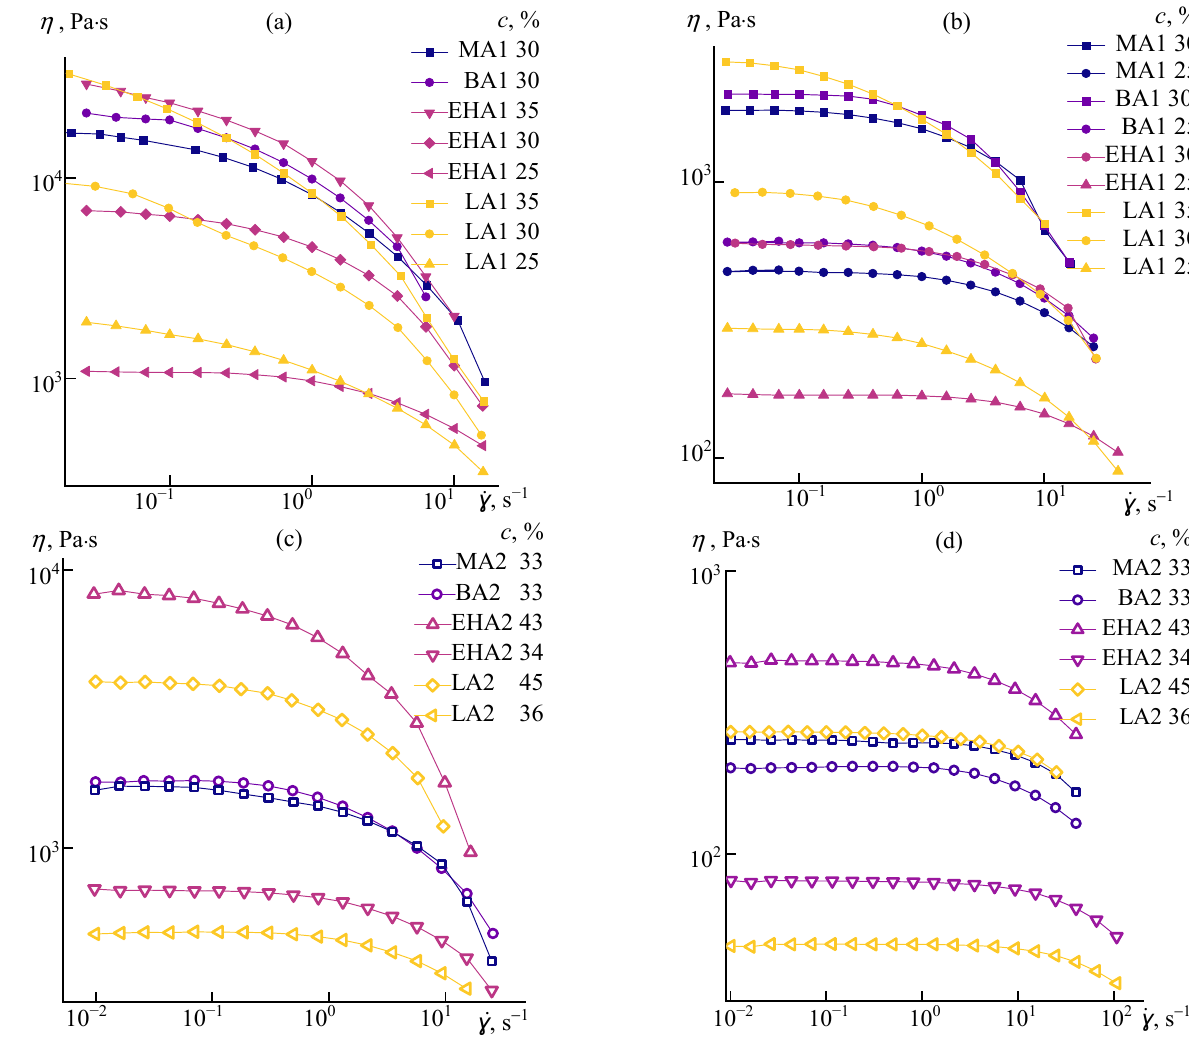
Figure 3. Flow curves of high molecular weight (AlkA1) and low molecular weight (AlkA2) concen- trated solutions of different concentrations at 25 °C ( a , c ) and 70 °C ( b , d ). The concentrations are indicated in the legend.